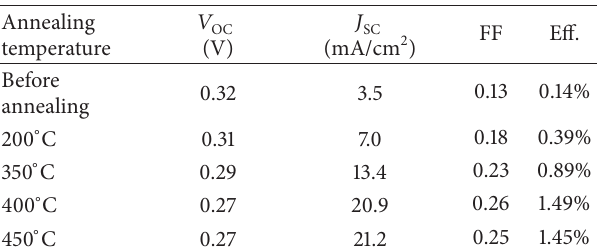
Table 1: The photovoltaic parameters of Gr-Si solar cell before annealing and after thermal annealing processes at different tem- peratures.